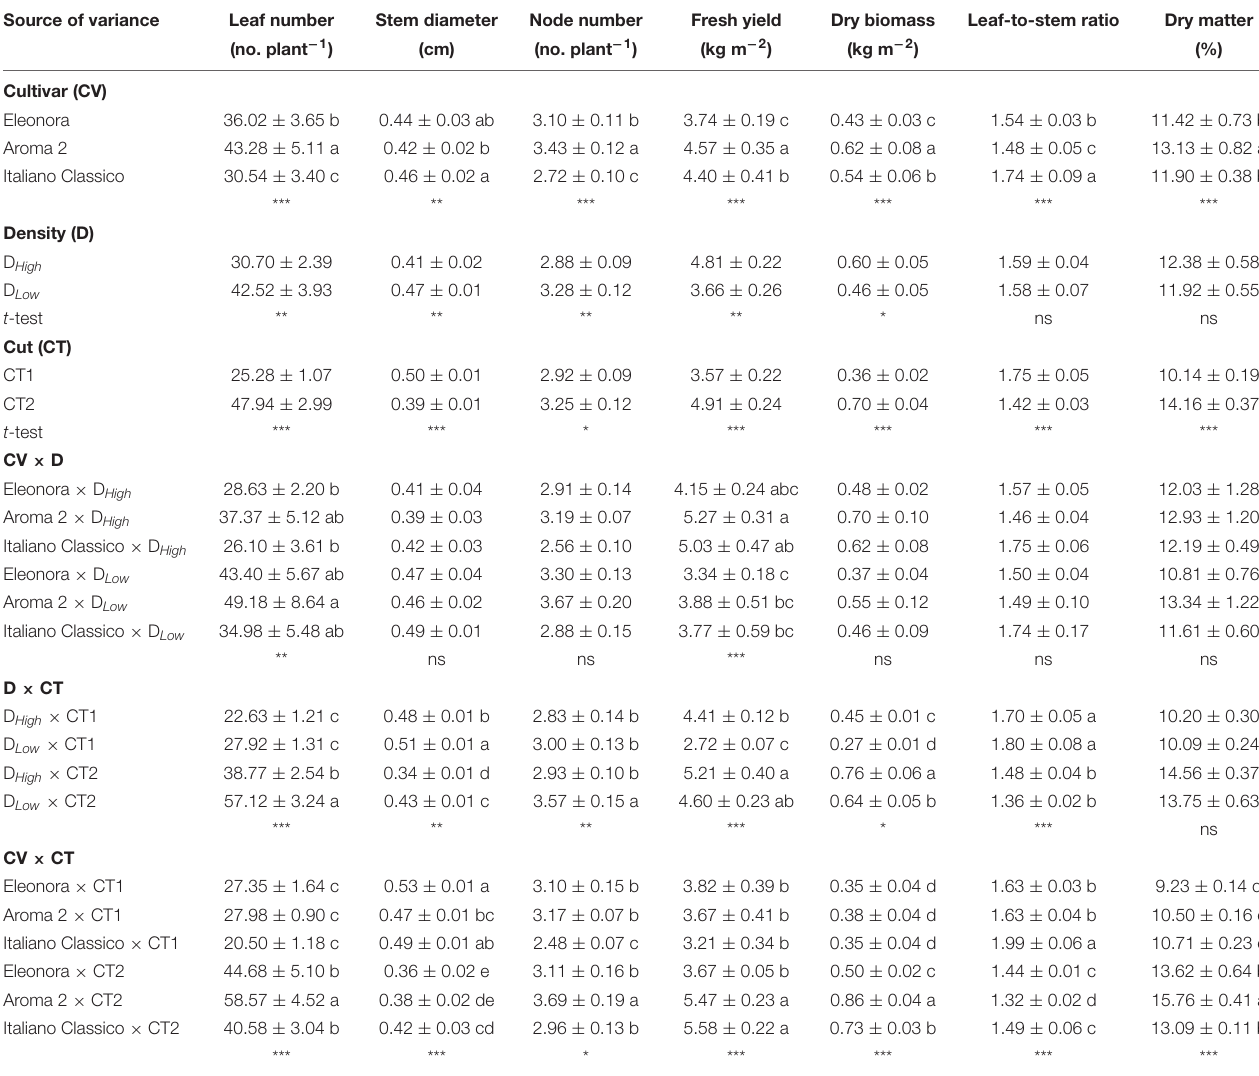
TABLE 1 | Leaf number, stem diameter, node number, fresh yield, dry biomass, leaf-to-stem ratio, and dry matter of Genovese basil cultivars Eleonora, Aroma 2, and Italiano Classico in light of density and cut treatments. Source of